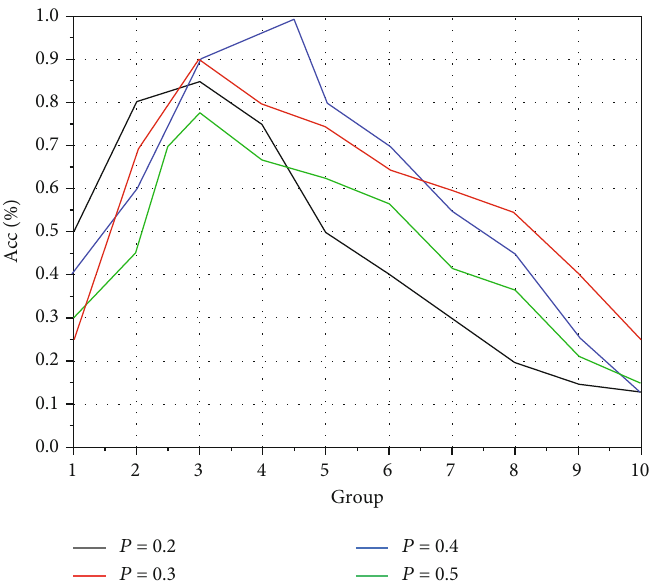
Figure 6: E ff ect of some parameters on the accuracy of the